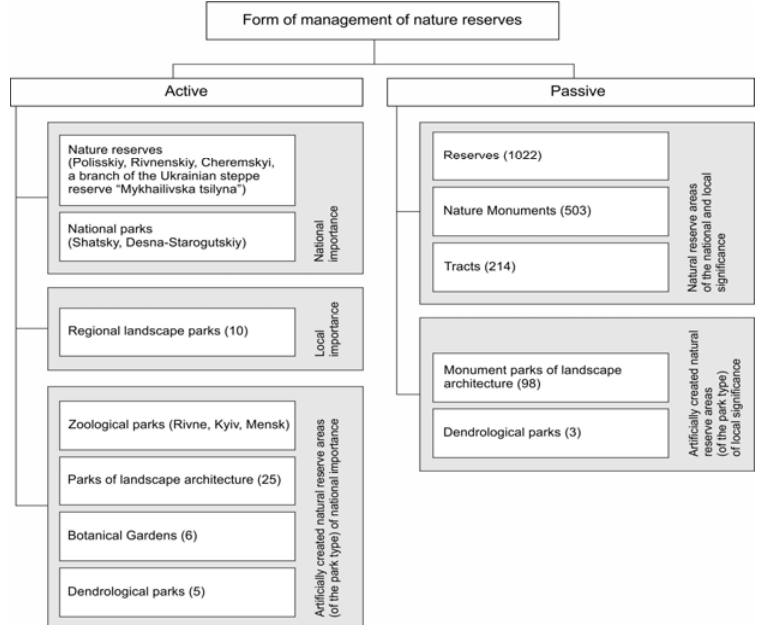
Fig. 4. Form of management of the territories and objectsof the Natural Reserve Fund of Ukraine in the Polissya